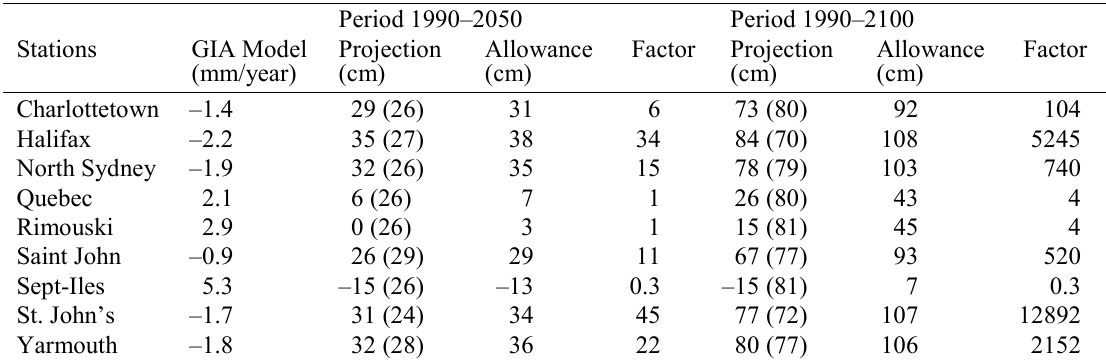
Table 2 Summary of GIA model predictions of vertical crustal motion and sea-level change, mean of the 5- and 95-percentile level of projections of sea-level rise (5- to 95-percentile range), allowances, and multiplying factors by which frequency of flooding events will increase with a sea-level rise of ∆z at tide- gauge stations. Period